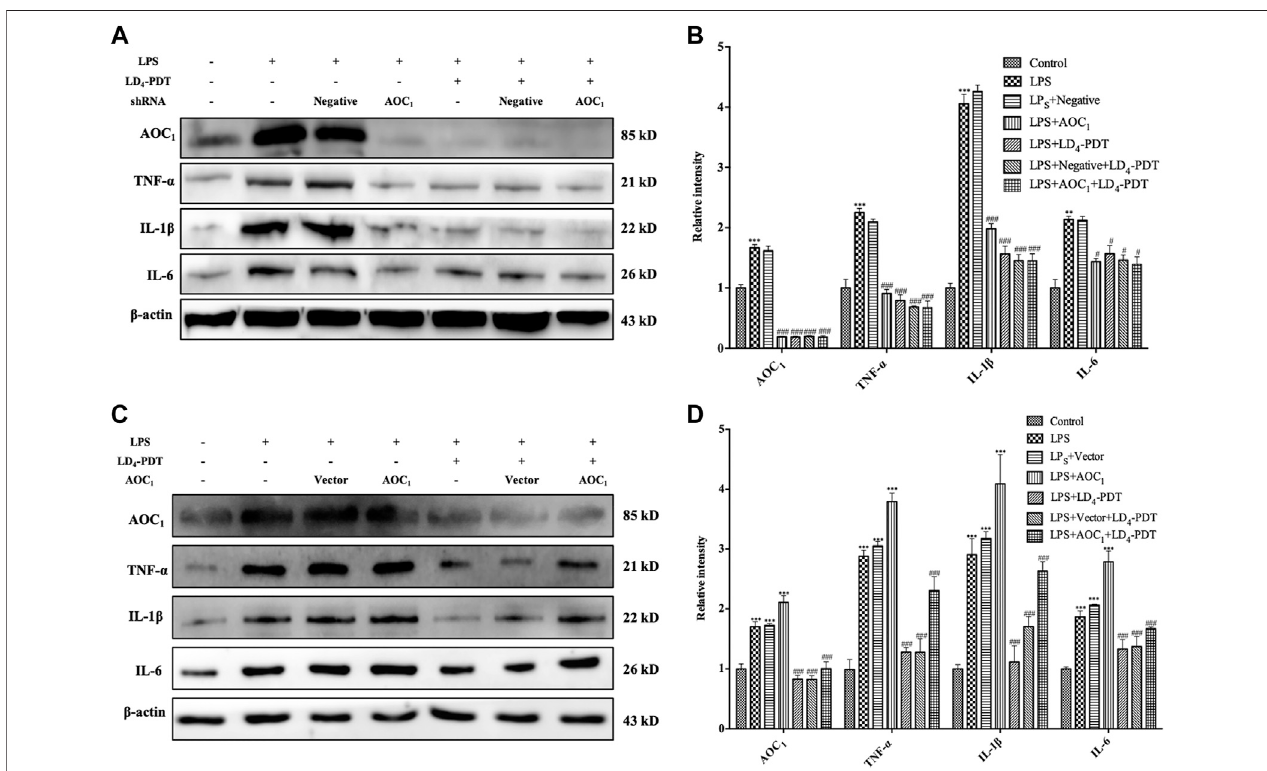
FIGURE7| LD 4 -PDTprotectedintestine via inhibitionofAOC 1 . (A,B) LD 4 -PDTeffecton TNF- α , IL-6 and IL-1 expressionin AOC 1 knockdownHCoEpiCcells. (C,D)